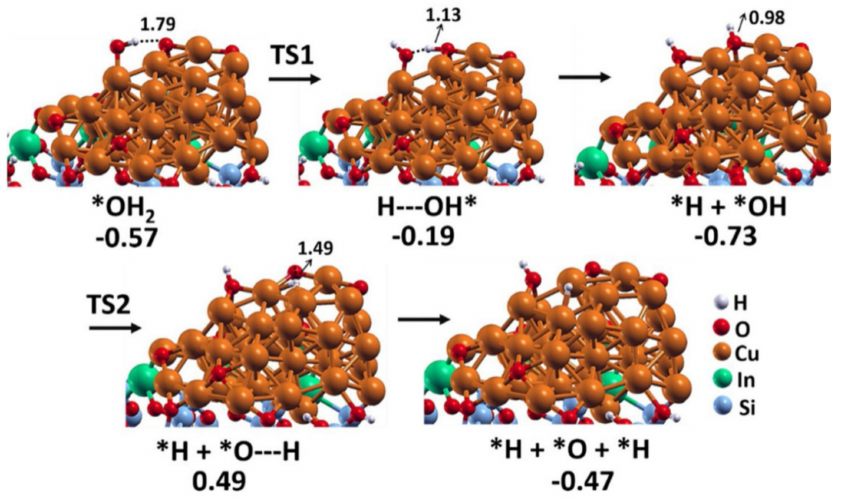
Figure 4. The complete reaction path for the dissociation of H 2 O to *H + *O [97]. Copyright Elsevier,